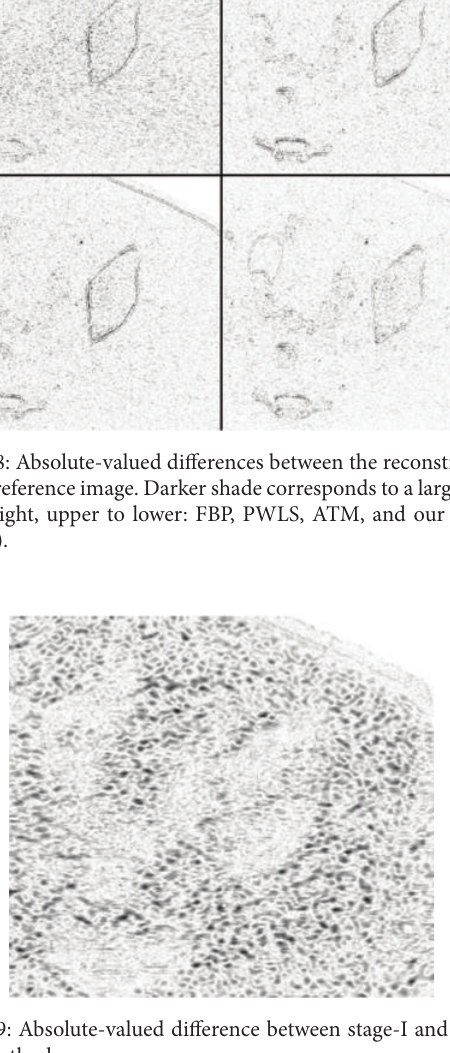
Figure 11: Head reconstruction. Images are listed left to right and displayed in HU range of [−170,250] . First row: reference image, PWLS. Second row: our method (stage II), ATM. Third row: our method (stage I), FBP.